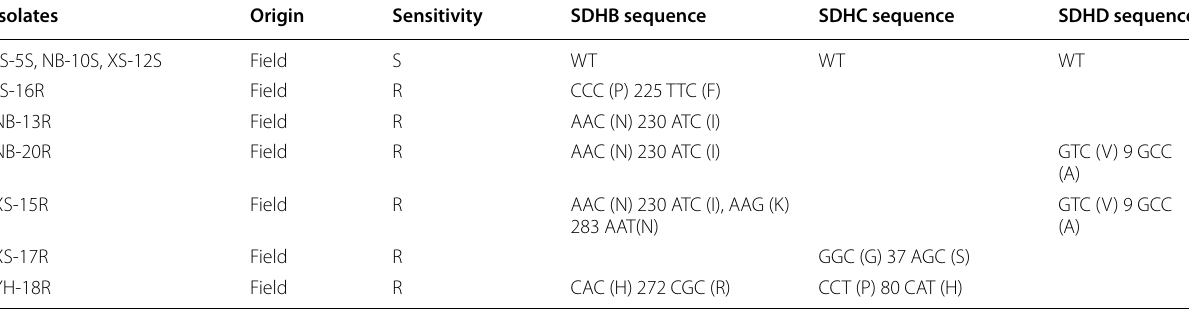
S indicates an isolate is sensitive to fluxapyroxad; R indicates an isolate is resistant to fluxapyroxad